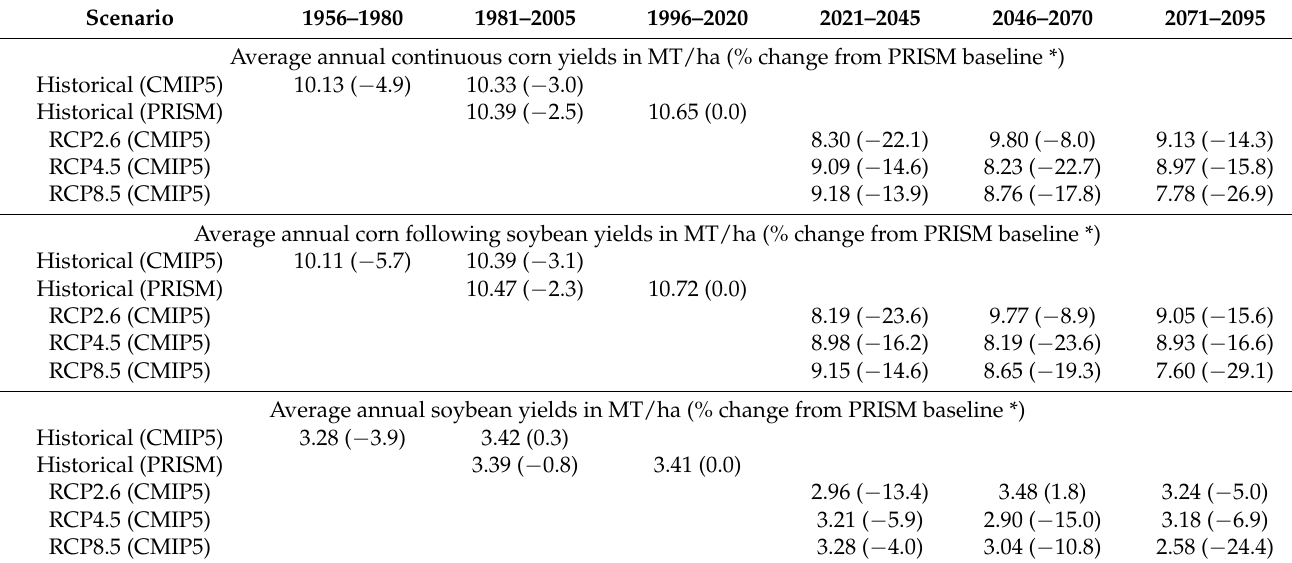
Table 9. Simulated impacts of climate scenarios on average annual corn and soybean yields based on 2019–2021 management practices and crop genetic potential: MT/ha (% changes from PRISM).